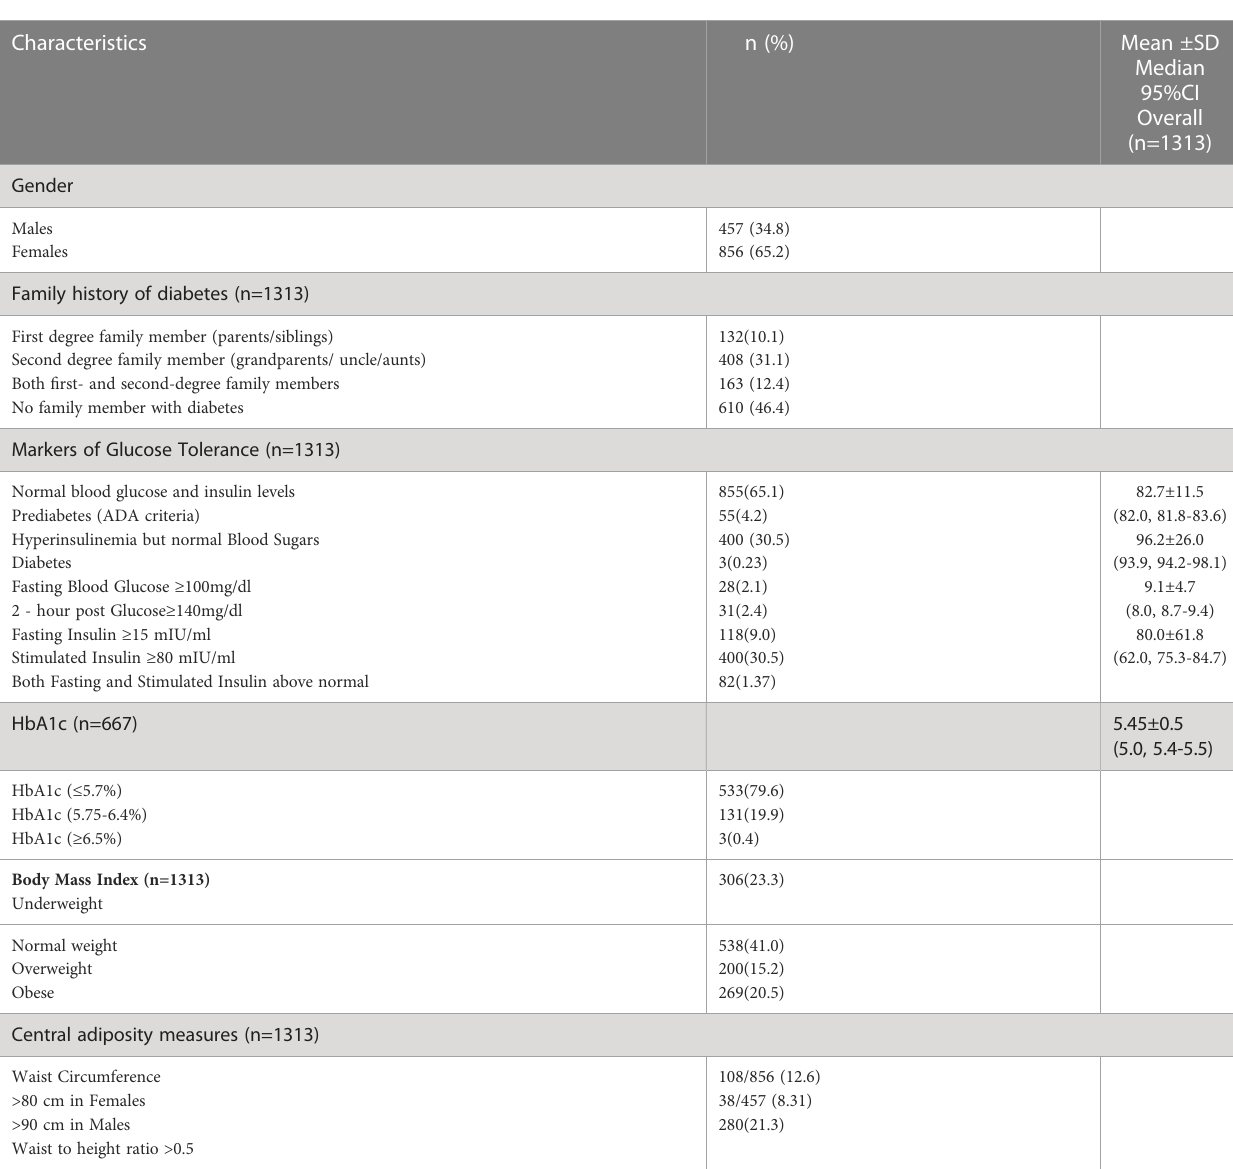
(Table 2). A higher percentage of prediabetics were obese (31.3%), or had WHtR >0.5 (24.4%) or higher percent body fat (55.0%) as compared to those with HbA1c < 5.7%, although there was no signi fi cant difference between the two groups (Table 2). However, the percentage of prediabetics with percent body fat exceeding 30% was signi fi cantly higher.